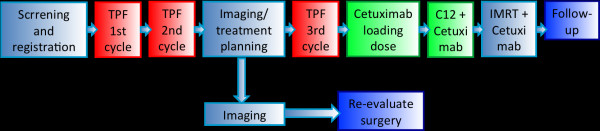
trial flow-chart.